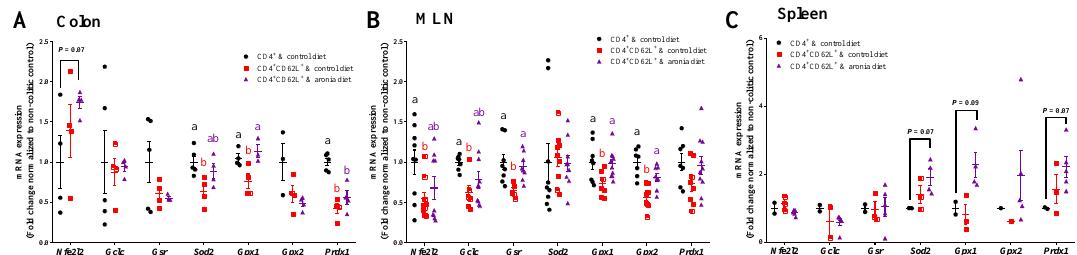
Figure 5. Aronia consumption maintains mRNA expression of endogenous antioxidant enzymes. Splenic CD4 + CD62L + cells from C57BL / 6J mice were transferred to Rag1 - / - mice. Mice consumed the AIN-93M diet (colitic control) or aronia-supplemented diet for five weeks. A third group of Rag1 - / - mice received splenic CD4 + cells, consumed AIN-93M diet, and served as the non-colitic control. The mRNA expressions of transcription factor of Nfe 2l2 (erythroid-derived 2-like 2) and the downstream antioxidant enzymes of Gclc (glutamate-cysteine ligase-catalytic subunit), Gsr (glutathione reductase), Sod2 (superoxide dismutase 2), Gpx1 (glutathione peroxidase 1), Gpx2 (glutathione peroxidase 2), and Prdx1 (peroxiredoxin 1) in the ( A ) colon ( n = 4–5 / group), ( B ) mesenteric lymph node (MLN) ( n = 9–10 / group), and ( C ) spleen ( n = 3–5 / group). Gene expression was normalized to Eef2 (eukaryotic translation elongation factor 2) and Rplp0 (ribosomal protein large P0) genes. Bars bearing di ff erent letters indicate significant di ff erences between treatments ( p < 0.05). Data are means ±